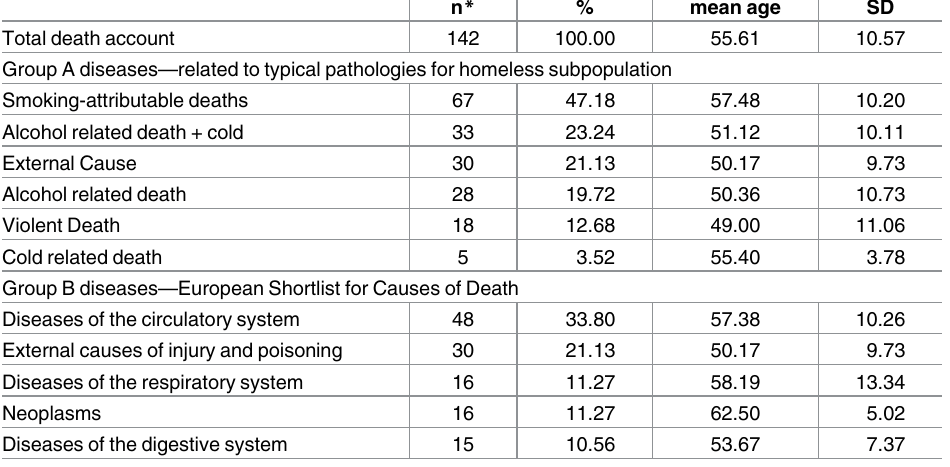
Table 2. Causes of death (n (cid:21) 5).